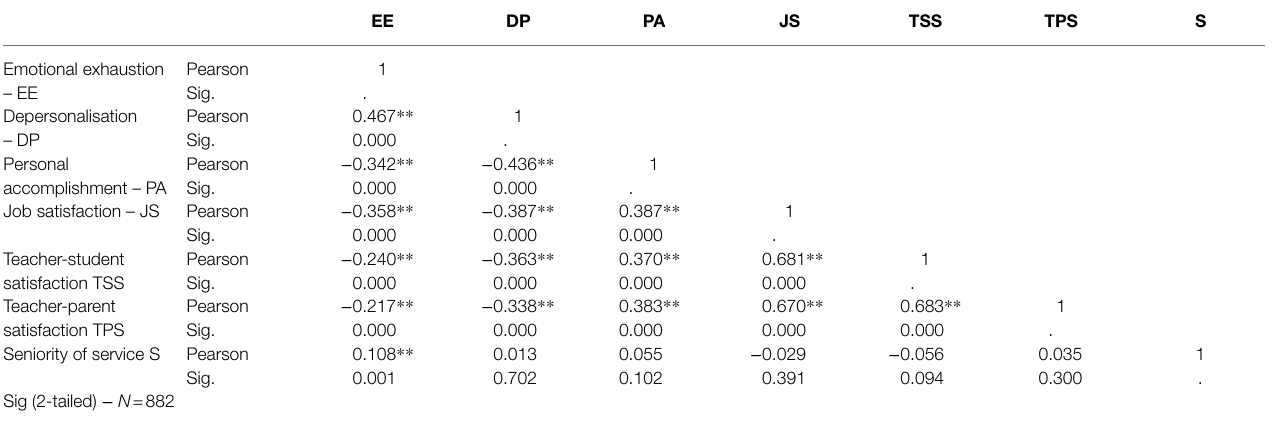
TABLE 1 | Pearson correlations.